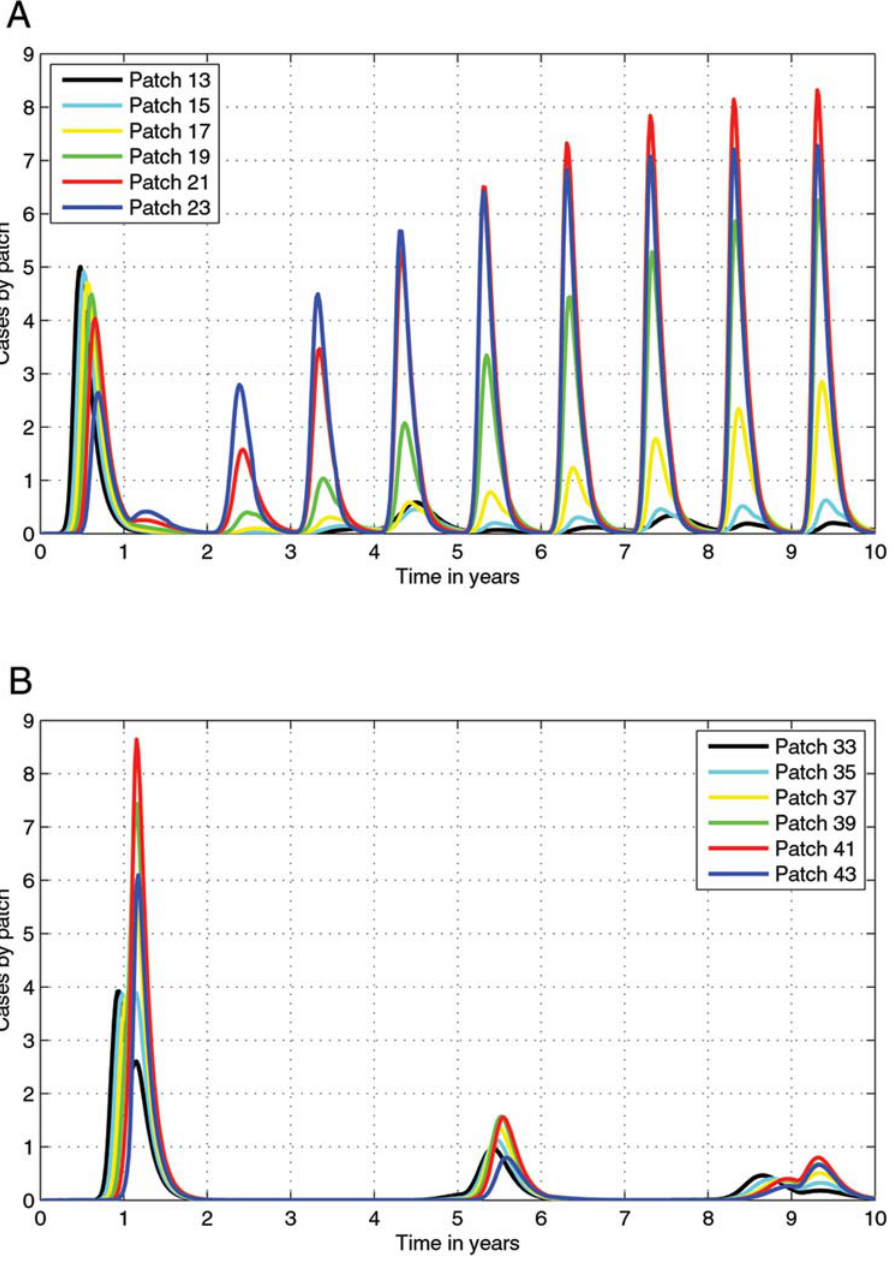
Figure 2. Time series for individual patches nearest (a) the vaccine corridor in the simulation with vaccines before the river and (b) the river in the simulation with vaccine corridor behind the river.